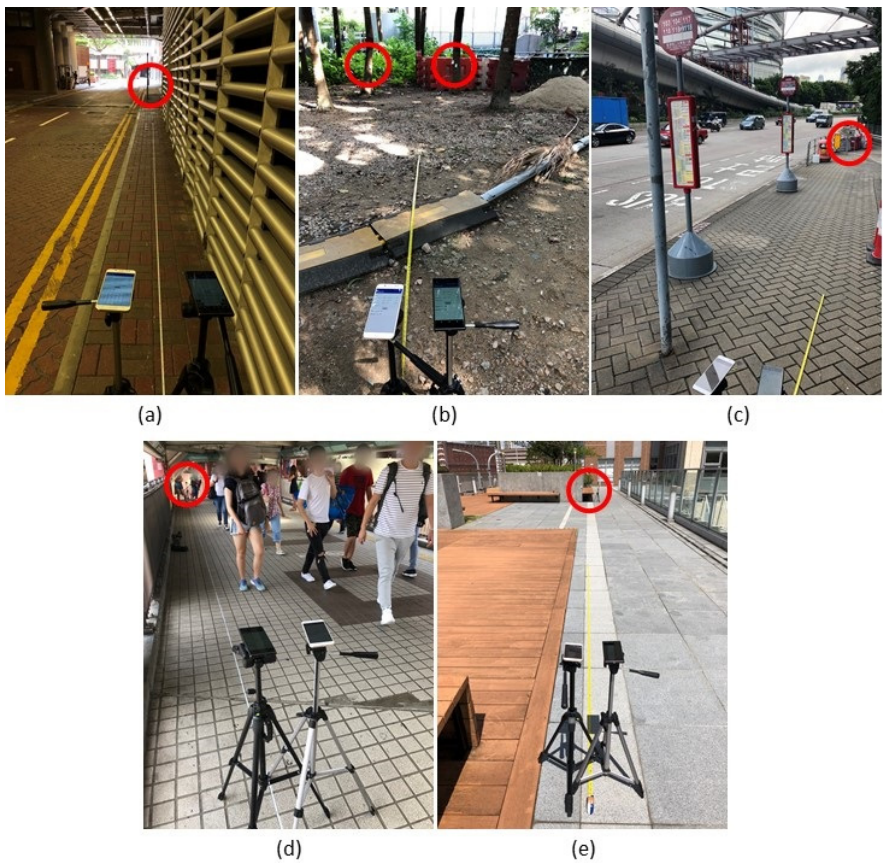
Figure 2. Experimental setup of signal coverage test and environmental conditions test where the red circles indicate the location of iBeacons installed. ( a ) Signal coverage test. ( b ) Obstruction of tree. ( c ) High vehicle traffic. ( d ) Pedestrian traffic. ( e ) Control dataset.